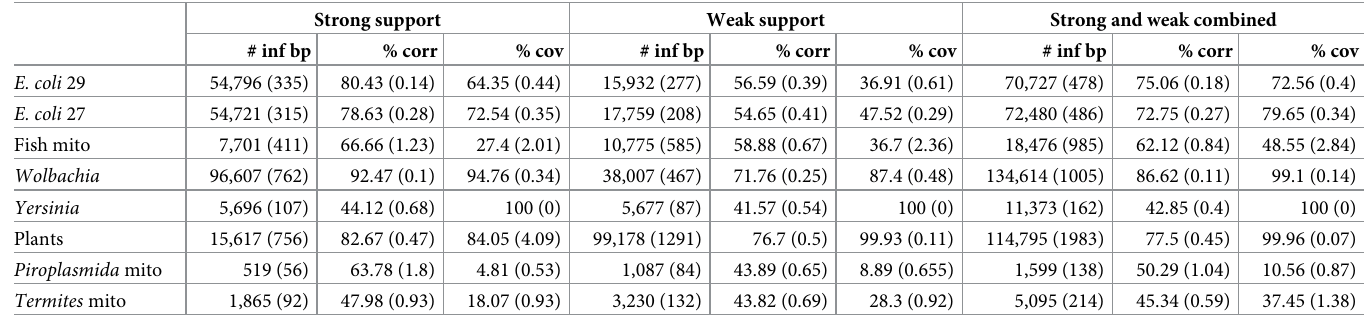
Table 2. Test results on different sets of genomes. As benchmark data, we used five sets of genome sequences from AF-Project [47] and sets of genomes from Wolbachia [48], Piroplasmida [49] and Termites [50]. For each data set, we generated up to 1,000,000 pairs of quartet blocks as described in the main text. The table shows the number of informative block pairs (‘# inf bp’), i.e. the number of block pairs for which we obtained either strong or weak support for one of the three possible quartet topologies of the involved sequences. In addition we show the percentage of correct quartet topologies (with respect to the respective reference tree), out of all informative block pairs, as well as the ‘coverage’ by quartet blocks, i.e. the percentage of sequence quartets for which we found at least one informative block pair. Standard deviations are shown in parentheses. For each data set, we obtained 1,000,000 block pairs, except for the three sets of mitochondrial genomes, where it was not possible to find this number of block